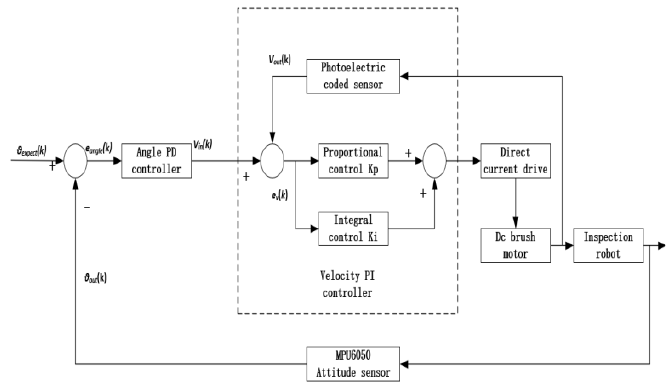
Figure 13. Block diagram of dual closed-loop PID controller.